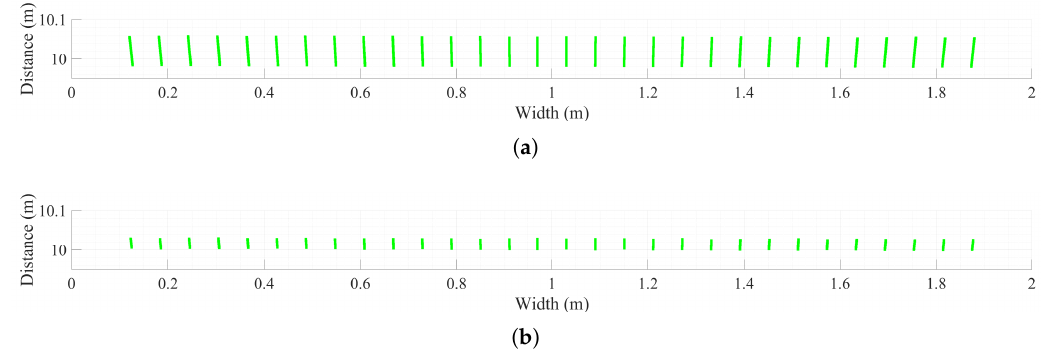
Figure 10. Top-view distance in the legacy ( a ) and OCDMA ( b ) modes.